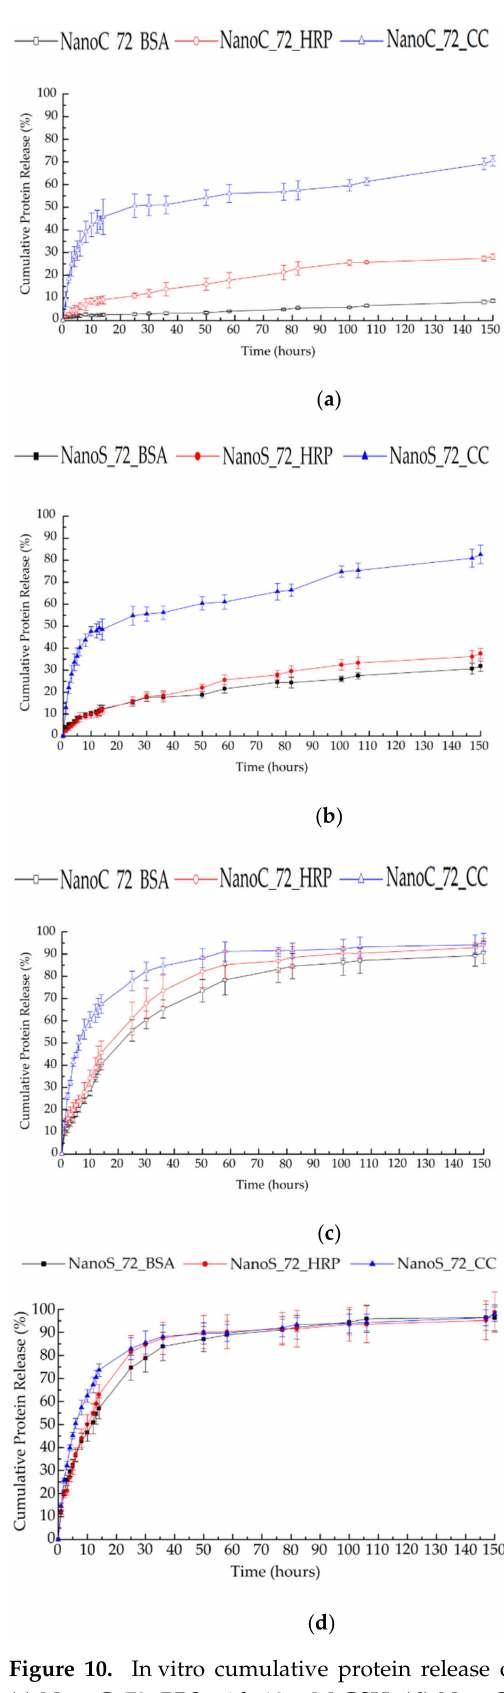
Figure 10. In vitro cumulative protein release of ( a ) NanoC_72 in PBS; ( b ) NanoS_72 in PBS; ( c ) NanoC_72, PBS with 10 mM GSH; ( d ) NanoS_72, PBS with 10 mM GSH. The measurements were performed in